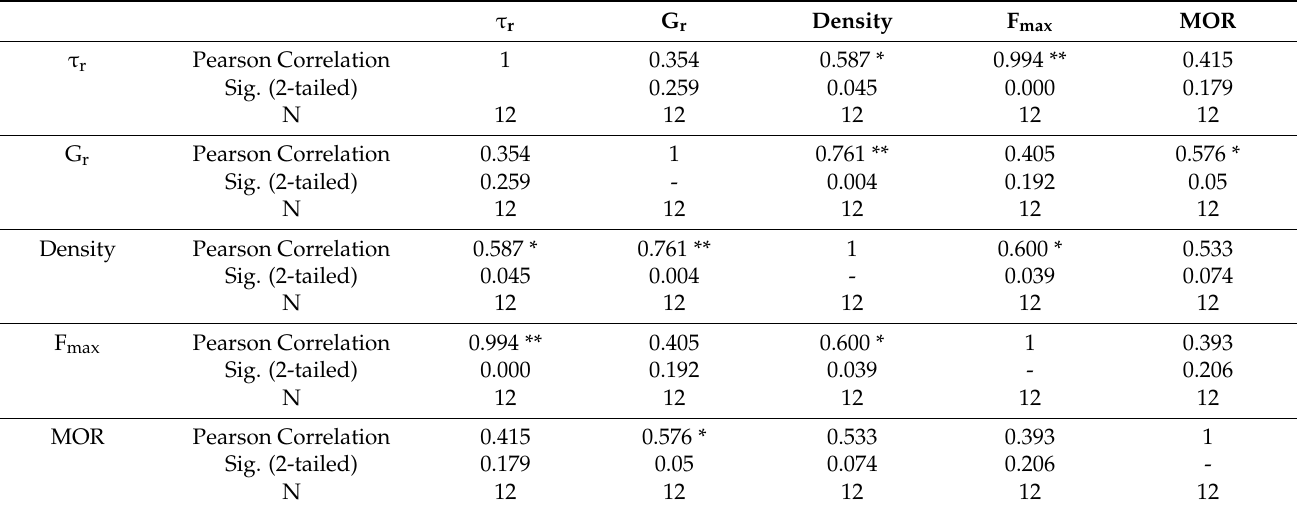
Table 4. Correlation between the test variables.